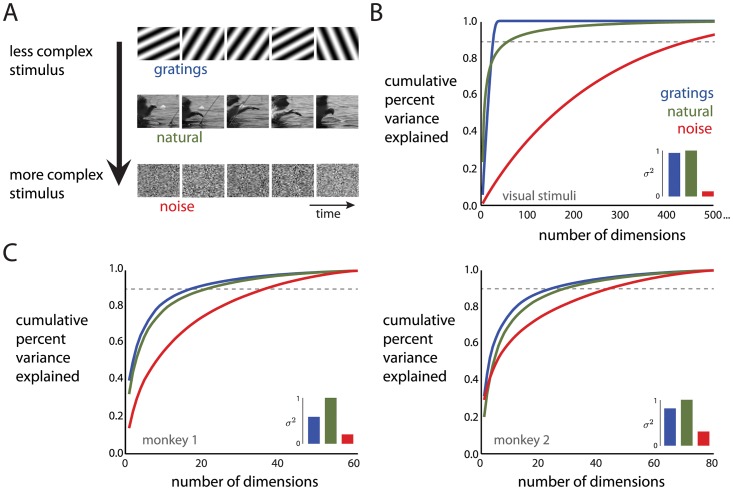
Dimensionality of movie stimuli and population responses to those movies.A: Example frames of the movies for the gratings movie, natural movie, and noise movie. B: For each stimulus, cumulative percent variance of the stimulus pixel intensities explained by different numbers of dimensions. Dashed line corresponds to 90% of the variance explained. Inset: summed variance of the pixel intensities, normalized by the maximum variance across movies. C: For each stimulus, cumulative percent variance of the population activity explained by different numbers of dimensions. Dashed lines correspond to 90% of variance explained. Left panel: monkey 1, 61 neurons. Right panel: monkey 2, 81 neurons. Insets: summed variance of each neuron’s activity, normalized by the maximum variance across movies.